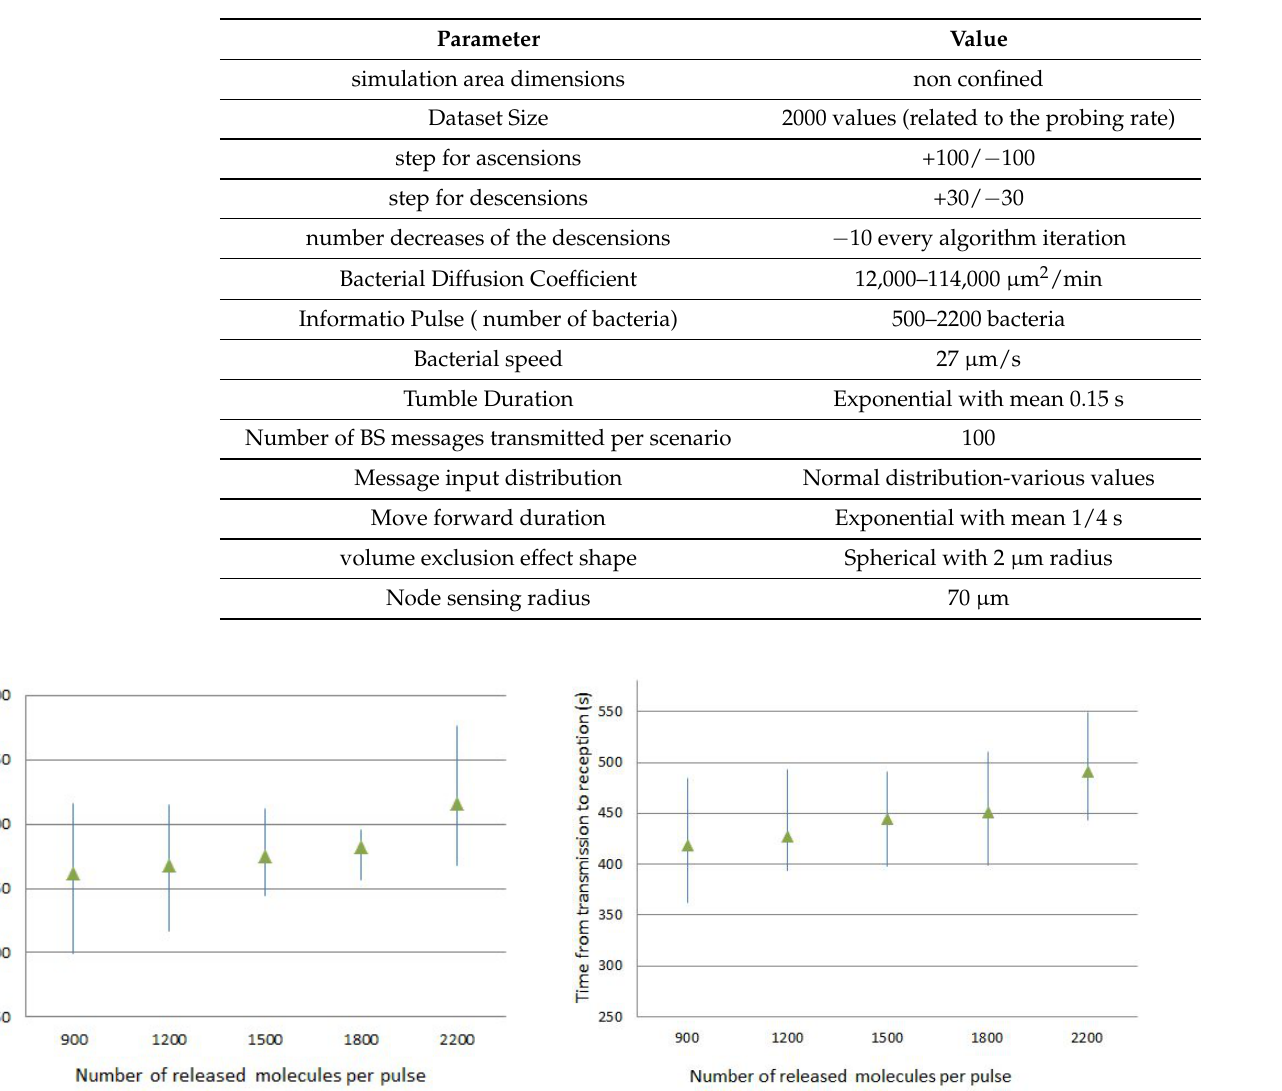
Table 1. Simulation parameters and values.